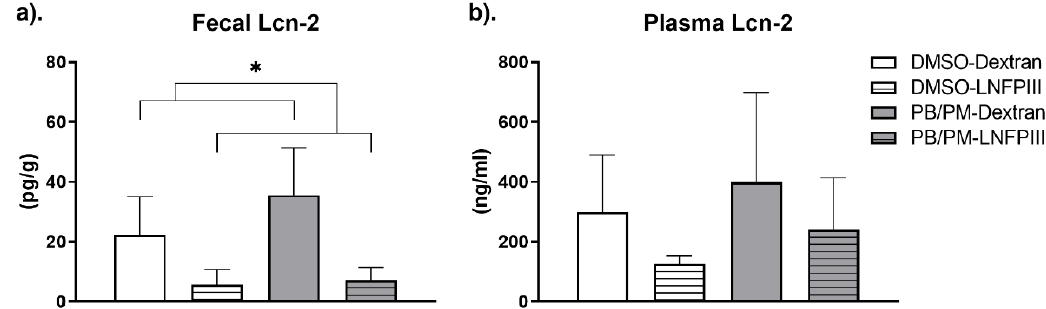
Figure 7. Bar plot showing levels of Lipocalin-2 (Lcn-2), as detected by ELISA, in mouse ( a ) fecal (pg / mL) and ( b ) plasma (ng / mL) samples from mice that were exposed to either DMSO-Dextran, DMSO-LNFPIII, PB / PM-Dextran, or PB / PM-LNFPIII and sacrificed 9 months later. Data are presented as mean ± SEM ( n = 6 / group). (* p < 0.05 post PB / PM